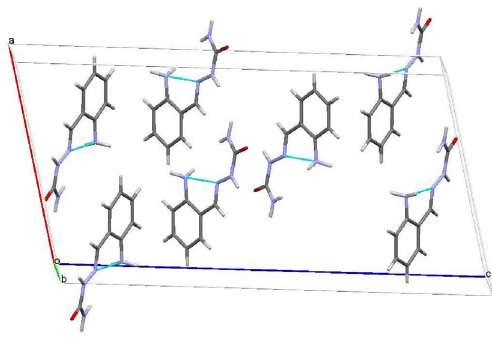
Figure 2. Unit cell packing diagram of molecule, 2.